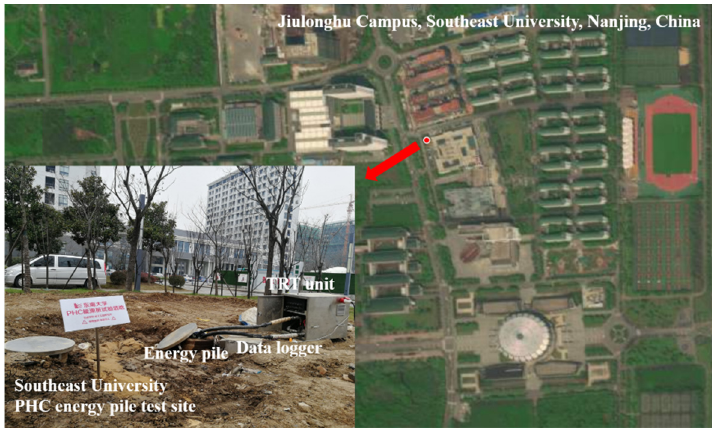
Figure 1. Location of the experimental site for the PHC energy pile.